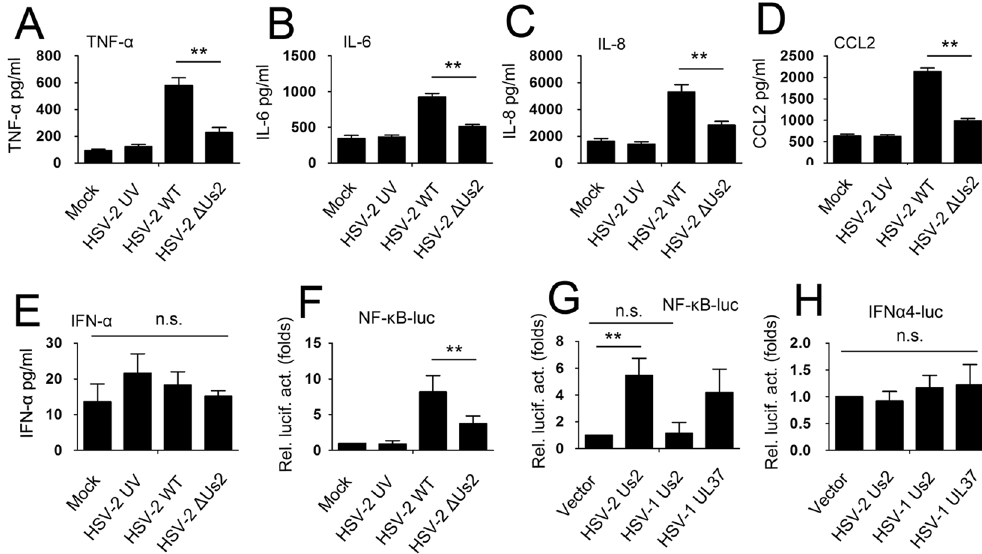
Figure 1. Effect of Us2 on NF- κ B activity and proinflammatory cytokines and chemokines expression. ( A – E ) End1/E6E7 cells were infected with HSV-2 WT, HSV-2 UV, or HSV-2 Δ Us2 at 1 multiplicity of infection (MOI) for 12 h prior to ELISA analyses for TNF- α ( A ), IL-6 ( B ), IL-8 ( C ), CCL2 ( D ), IFN- α ( E ). ( F ) End1/E6E7 cells were transfected with NF- κ B dualluciferase reporter plasmid (NF- κ B-luc) for 12 h and infected with indicated viruses for 12 h prior to luciferase assays. ( G and H ) End1/E6E7 cells were transfected with the indicated plasmids for 24 h prior to luciferase assays. The results are the mean ± SD of triplicate cultures, representing three independent experiments ( ** P <